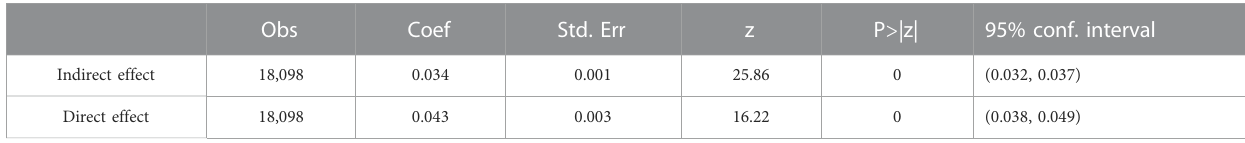
TABLE 6 Bootstrap test results.